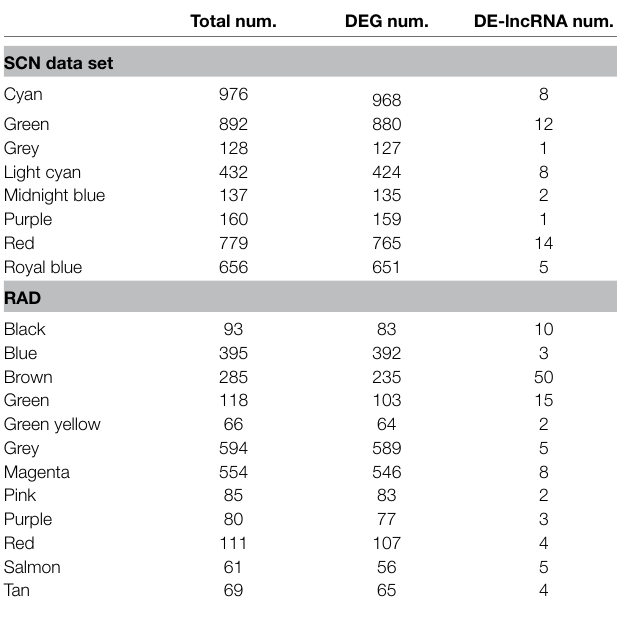
TABLE 2 | The number of DEGs and DE-lncRNAs in each co-expression module in SCN data set and RAD. Total